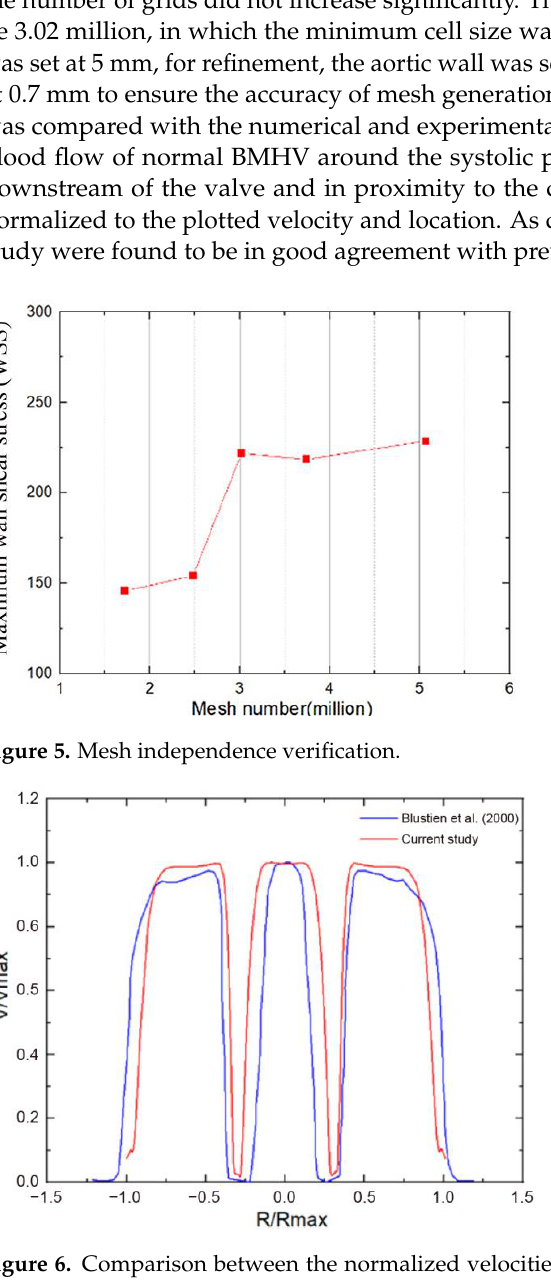
Figure 6. Comparison between the normalized velocities of the current study and the numerical study of Blustien et al.